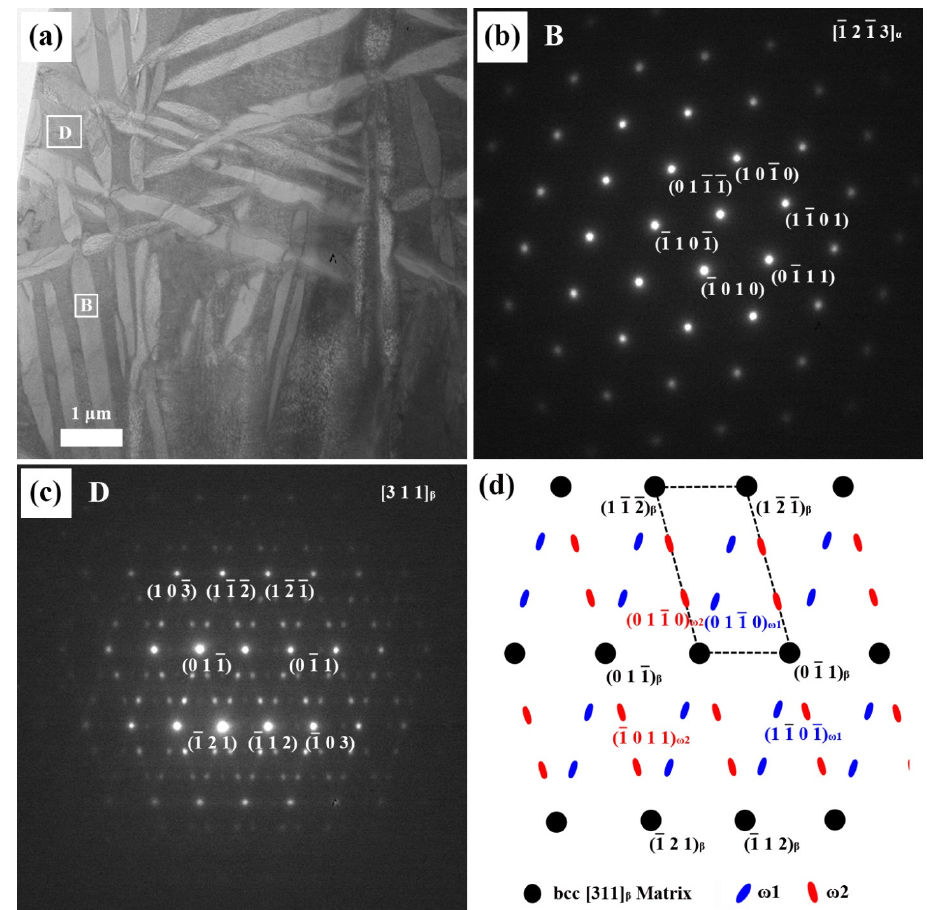
Figure 4. ( a ) The bright-field TEM image of the Ti-20Nb alloy; ( b ) corresponding selected-area electron diffraction (SAED) pattern from the bright area (B); ( c ) SAED pattern from the dark area (D); and ( d ) the key diagram of ( c